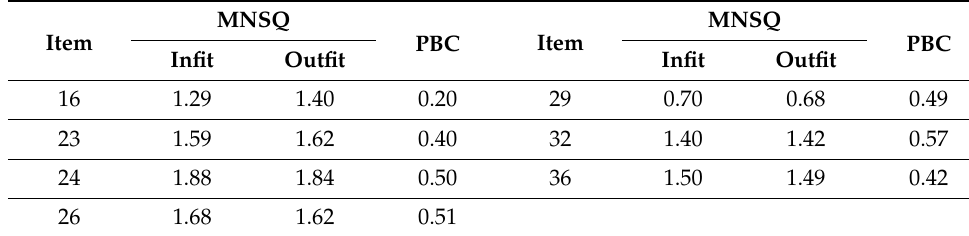
Table 8. Results of Item Relevance